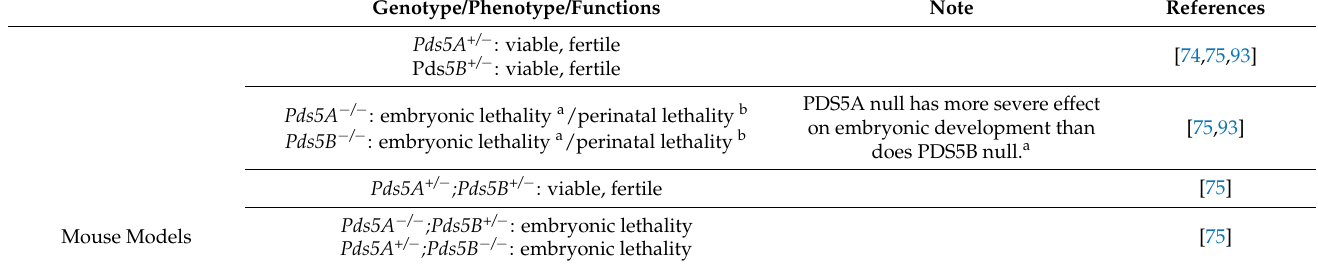
Table 1. Comparison of PDS5A and PDS5B functions in mouse models and cell